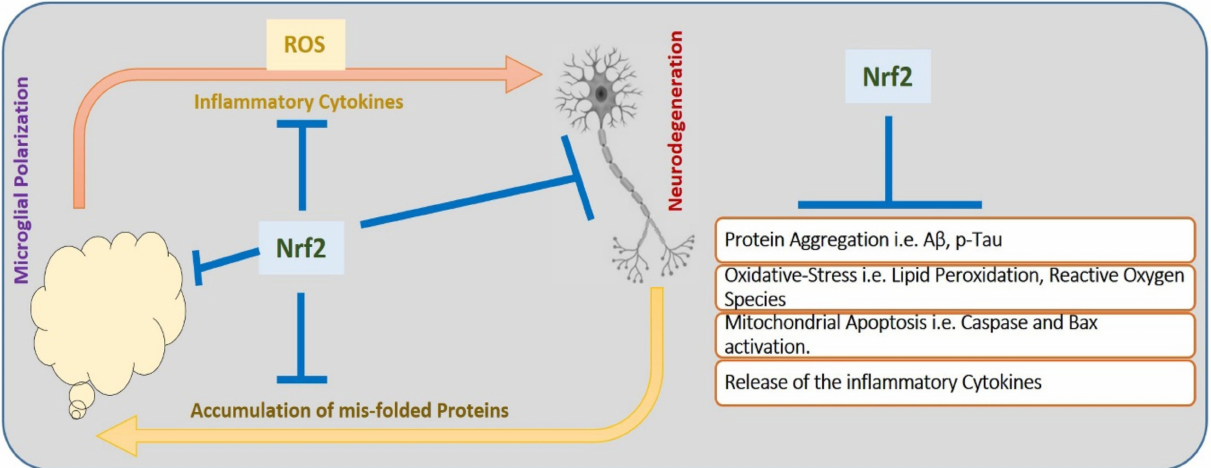
Figure 6. Nrf2 and its role against neurodegeneration. Nrf2 plays a key role against the elevated oxidative stress, neuroinflammation, and mitochondrial apoptosis in neuronal cells. Nrf2: nuclear factor-erythroid factor 2-related factor 2; ROS: reactive oxygen species; A β : amyloid